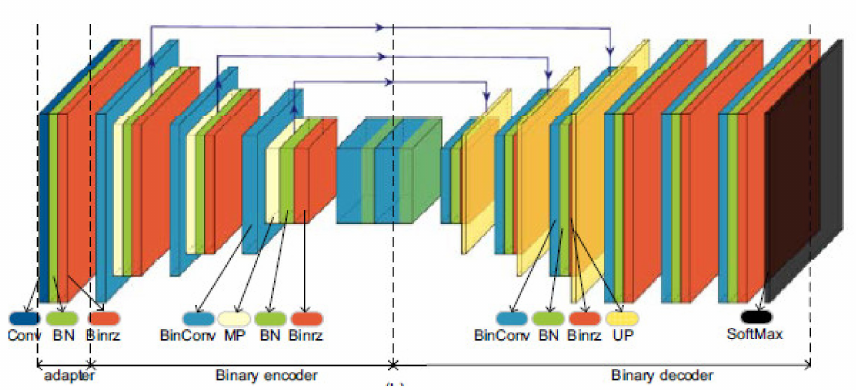
Figure 18. Binary Encoder–decoder neural network [66] (Reprinted with permission from ref. [66]. Copyright 2021